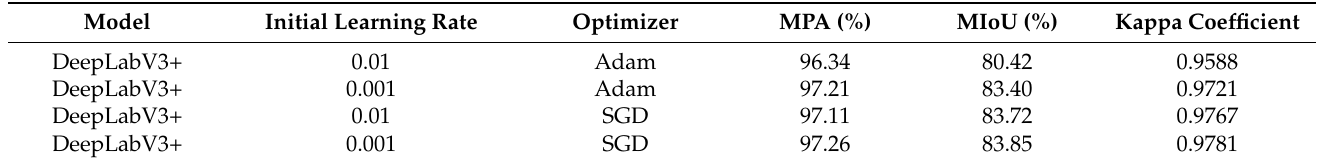
Table 4. Performance of DeepLabV3+